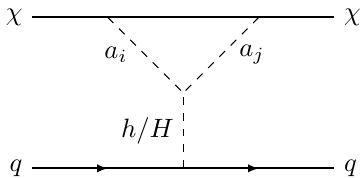
i indicates the